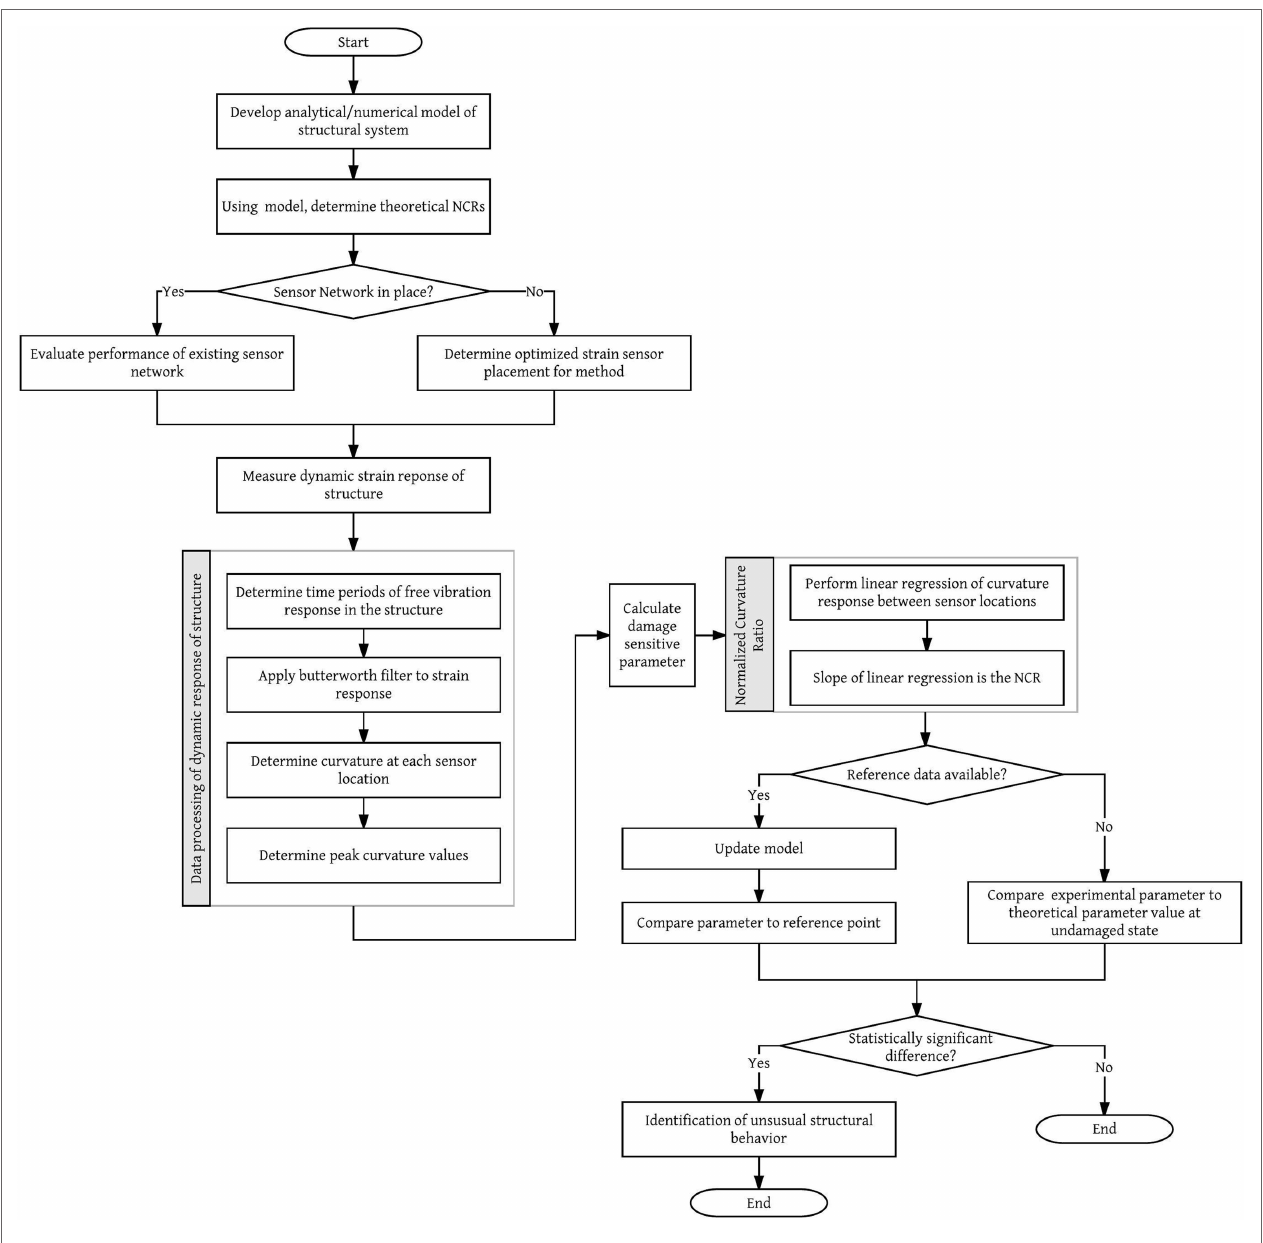
FIGURE 3 | Schematic representation of SHM method based on